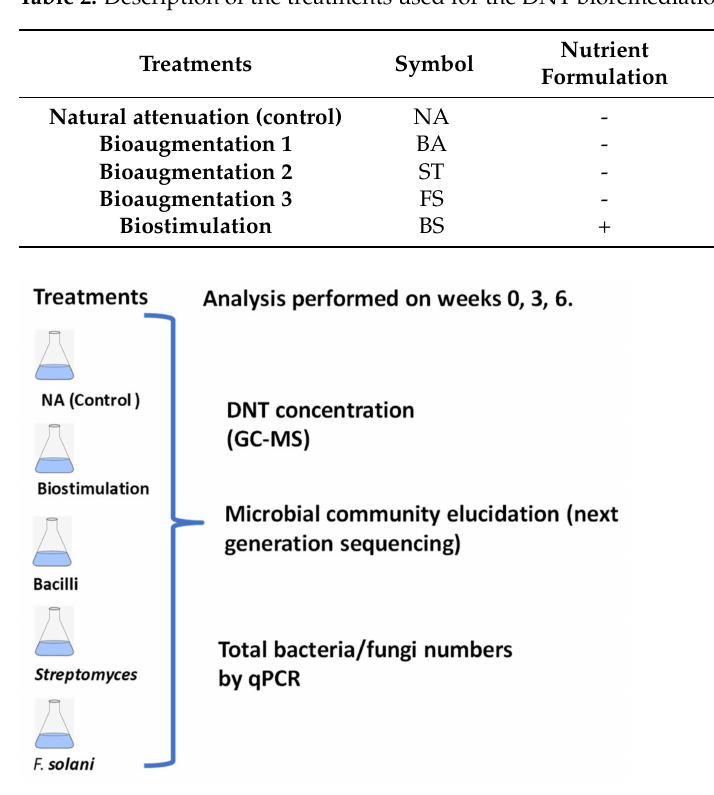
Table 2. Description of the treatments used for the DNT bioremediation study.